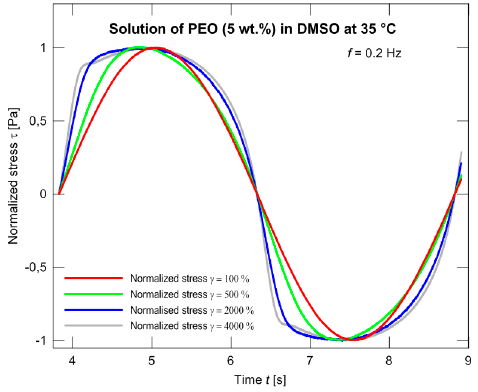
Figure 7. An evolution of the normalized stress curve with increasing strain.